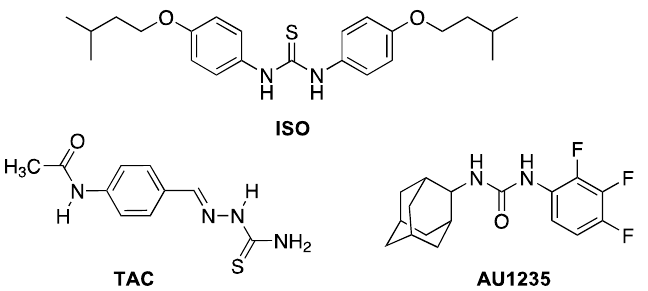
Figure 1. Chemical structures of isoxyl (ISO), thiacetazone (TAC) and AU1235. Mycobacteria have an extremely hydrophobic cell envelope that consists of a conven- tional plasma membrane; a layer of peptidoglycan; and a polysaccharide, arabinogalactan, which is esterified by mycolic acids, forming the inner leaflet of the mycomembrane [16]. The outer leaflet of the mycomembrane is composed of various complex lipids such as trehalose dimycolate (TDM), di- and polyacyl trehaloses, phthiocerol dimycocerosates and sulfolipids [17,18]. The mycobacterial cell envelope is an important target for antimycobac- terial compounds, with the most notable examples being first-line antituberculotics INH, which inhibits the FASII enoyl-ACP reductase InhA [19,20], and EMB, which interferes with the synthesis of arabinogalactan [21]. In recent years, several new inhibitors were found to target the cell envelope, for example, by affecting the transporter MmpL3, which transfers trehalose monomycolate (TMM) across the plasma membrane [22]. Once transferred to the periplasmic space, TMM is a substrate for the mycolyltransferases FbpA, FbpB and FbpC (also known collectively as the antigen 85 complex) that catalyze the transfer of mycolic acyl chains onto cell wall arabinogalactan or the synthesis of trehalose dimycolate (TDM), thus incorporating mycolates into the mycomembrane [23]. One of the MmpL3 inhibitors is an adamantyl urea AU1235 (Figure 1), which inhibits a range of mycobacterial strains, including MDR isolates of M. tuberculosis [22].